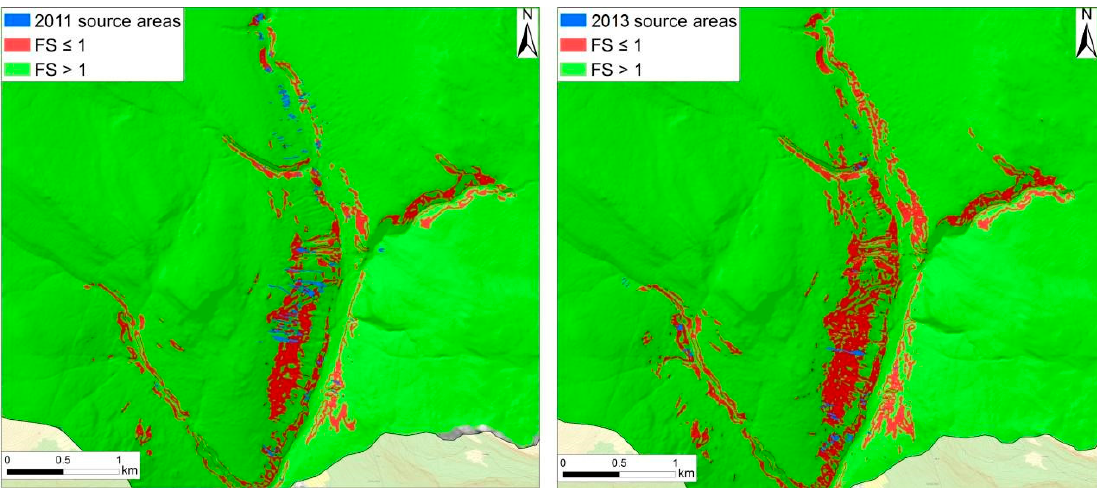
Figure 11. Graphical comparison between the spatial distribution of the 2011 ( left ) and 2013 ( right ) landslide source areas and the areas predicted as “unstable” (i.e., FS ≤ 1) at the end of the event by TRIGRS. Table 6. Outcome of the sensitivity analysis performed on several input parameters of the TRIGRS model, considering the 2013 landslide event.